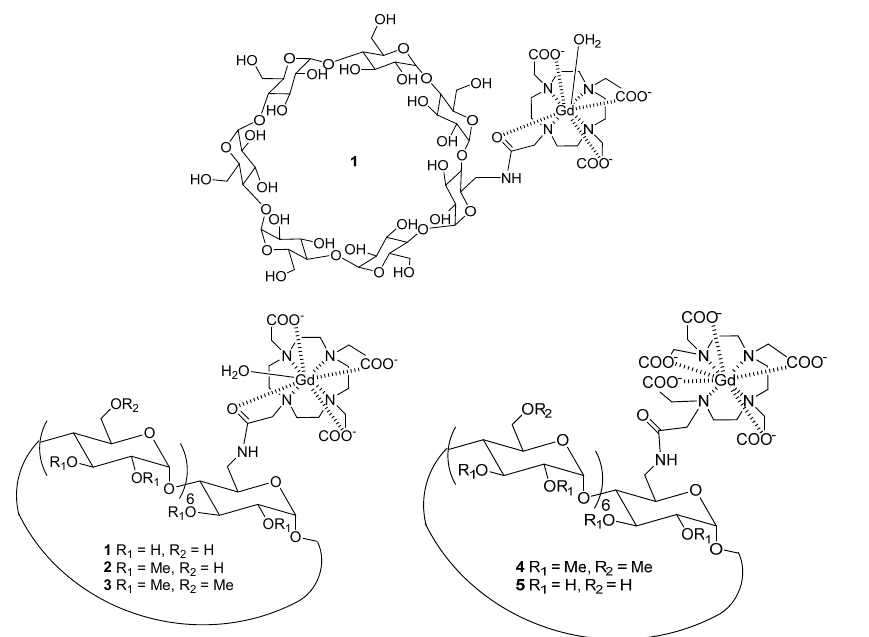
Figure 1. Structure of new contrast agents based on β -CDs-DOTAMA ( 1 – 3 ) and β -CDs-TTHAMA ( 4 and 5 ) ligands.